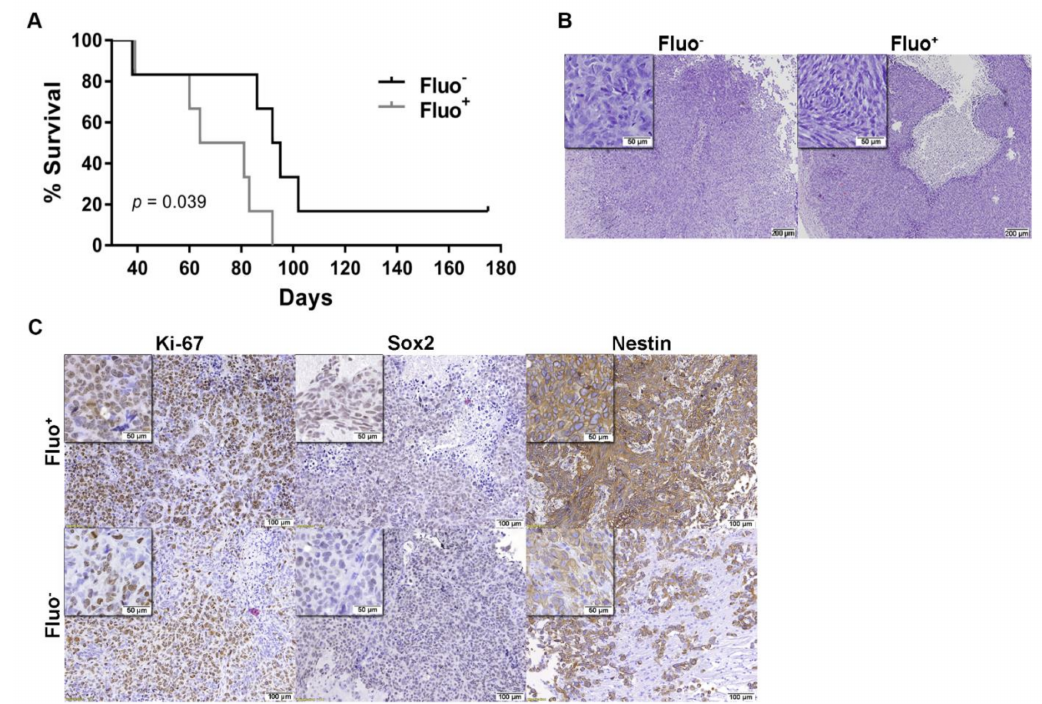
Figure 6. Autofluorescent cells are associated with increased aggressiveness in in vivo GBM xenografts. ( A ) Kaplan–Meier survival curves of NSG mice intracranially injected with Fluo − or Fluo + U251 GBM cells ( n = 6/group; Log–rank test, p = 0.039). ( B ) Representative images of hematoxylin and eosin staining in tissue sections at endpoint. ( C ) Representative images of Ki–67, Sox2 and